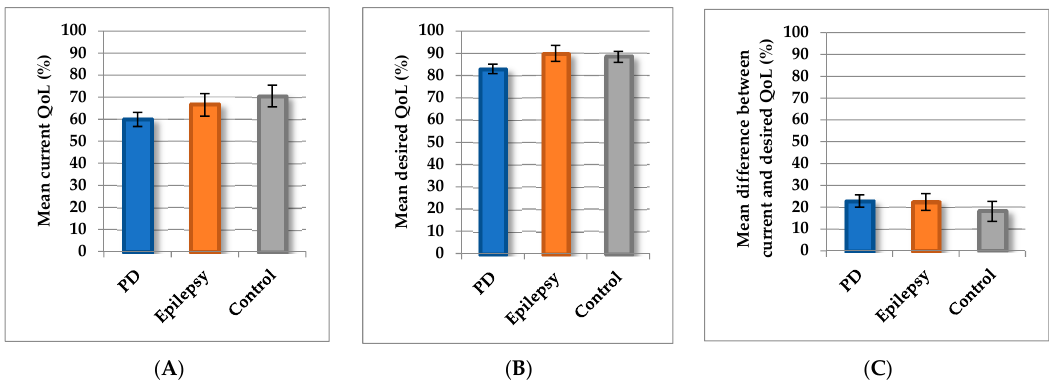
Figure 2. Quality of life in patients with Parkinson’s disease (PD), patients with epilepsy, and controls. ( A ) Mean current quality of life (QoL) according to patients with Parkinson’s disease (PD), patients with epilepsy, and controls (with 95%CI). ( B ) Mean desired QoL according to patients with PD, patients with epilepsy, and controls (with 95%CI). ( C ) Mean di ff erence between current and desired QoL according to patients with PD, patients with epilepsy, and controls (with